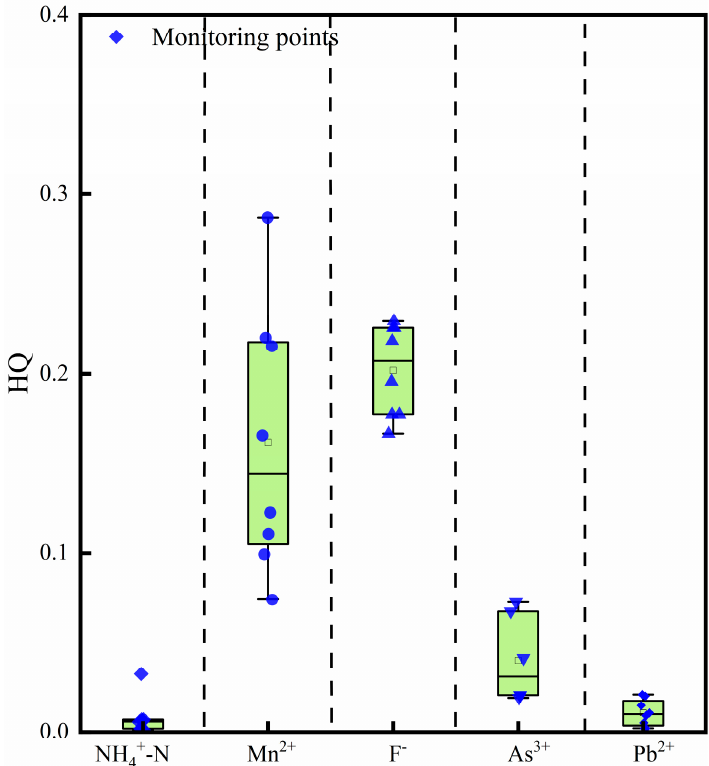
Figure 6. Box line map of groundwater hazard factor in the study area.